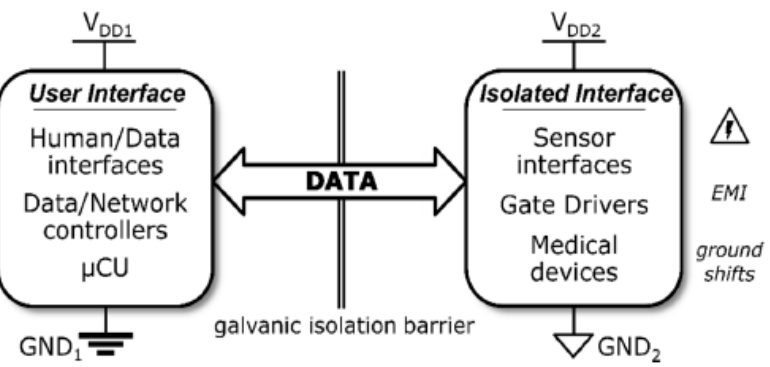
Figure 1. Simplified block diagram of a galvanically isolated system.